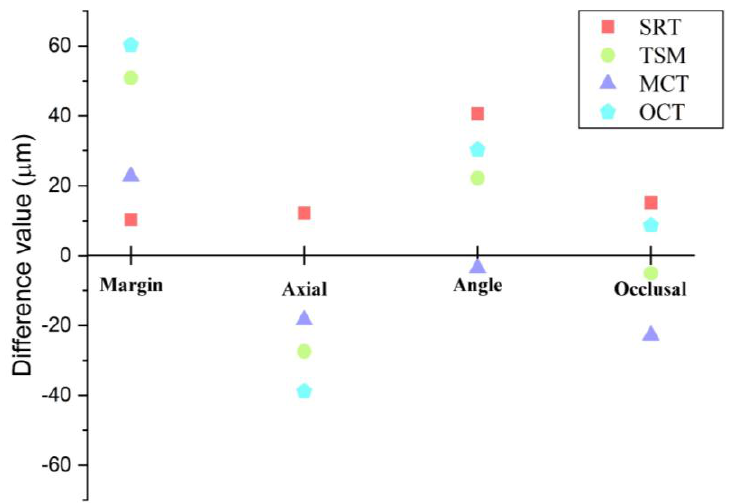
Figure 10. Differences in values compared to the cross-sectional method (CSM). The graph shows the difference from each method based on the CSM (baseline).